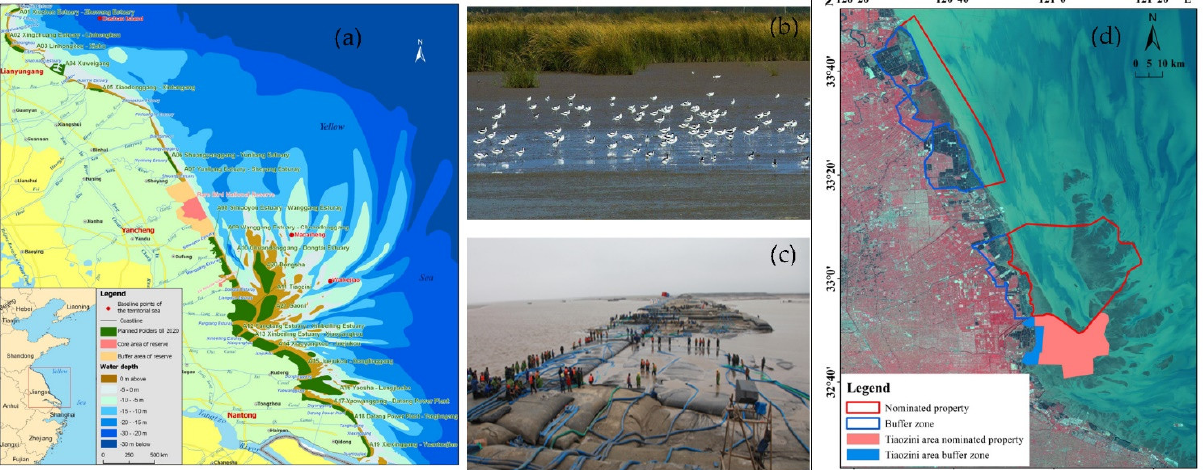
Figure 10. ( a ) planed polders in Jiangsu Tidal Flats [39]; ( b ) tidal flat birds; ( c ) reclamation photo; ( d ) the two components of the migratory bird sanctuaries along the Coast of Yellow Sea–Bohai Gulf of China (Phase I) [6].